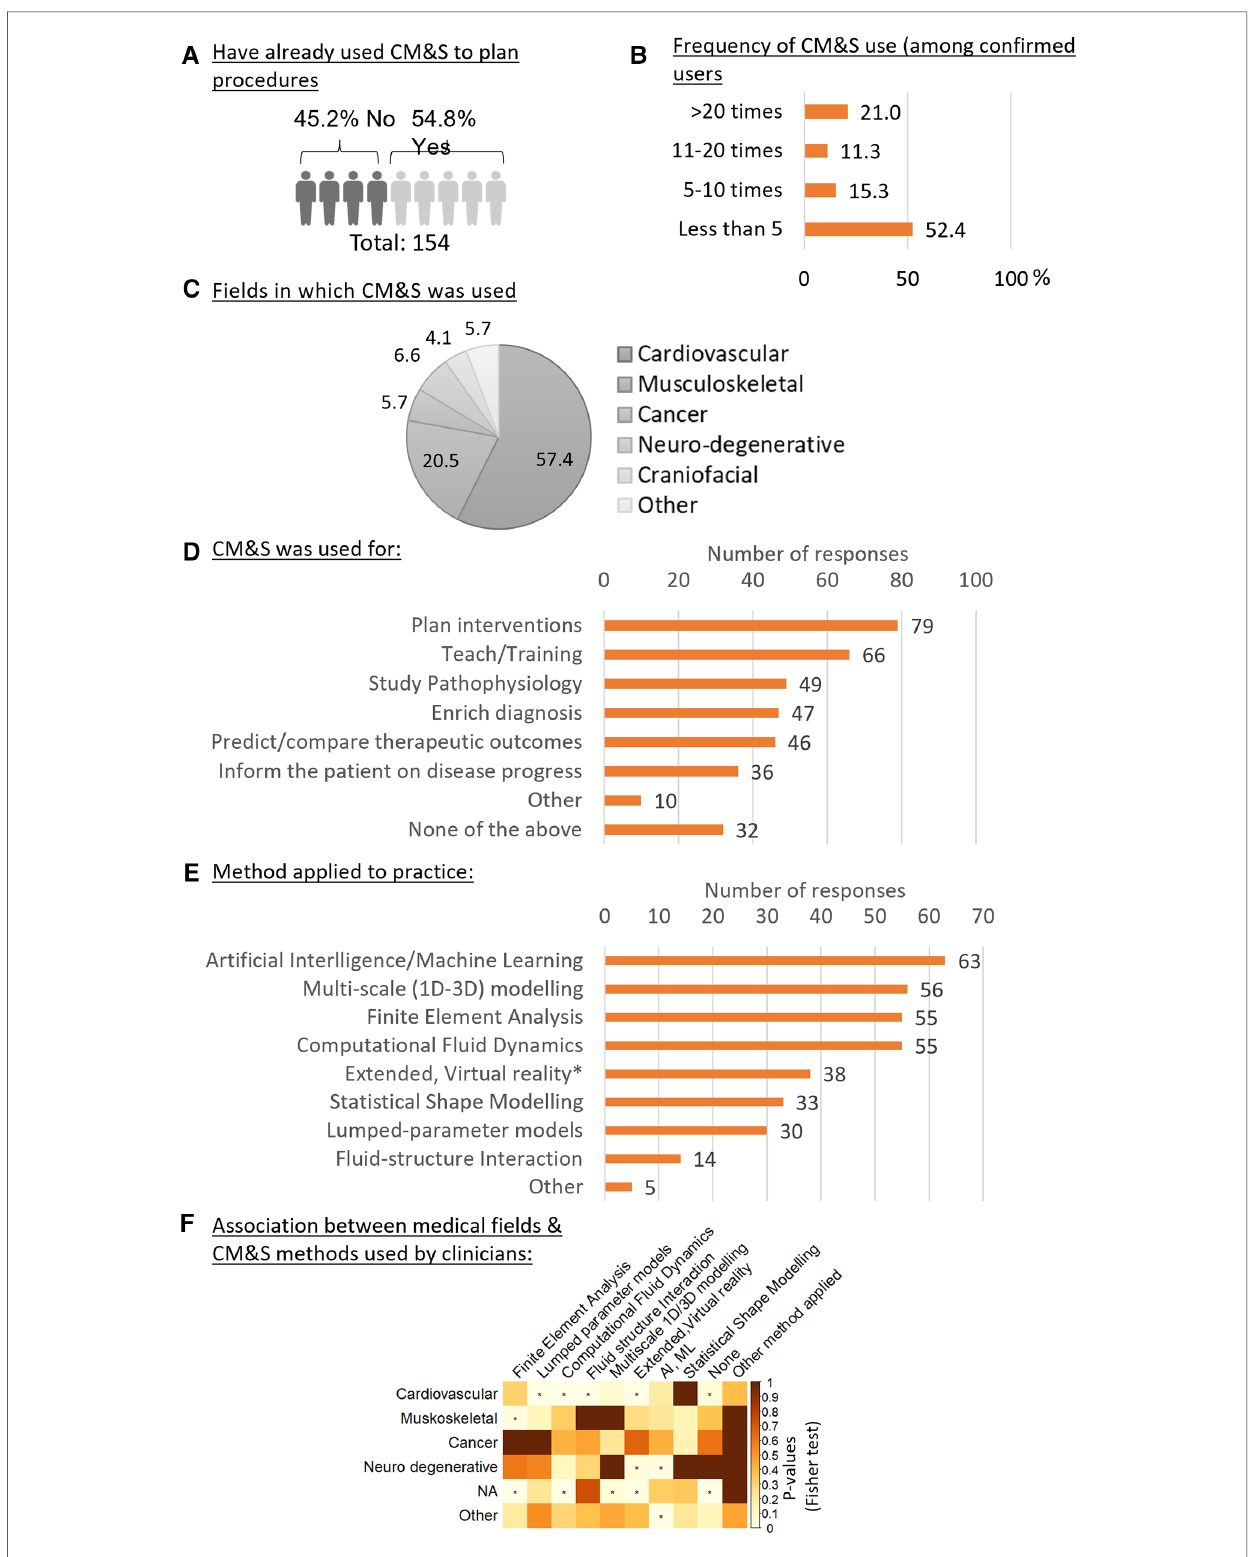
FIGURE 3 Usage of CM&S and related methods in the clinics. ( A ) percentage of clinicians who have already used CM&S for planning procedures (question #10). ( B ) Frequency of usage of CM&S among clinicians who have already used it to plan procedure. ( C ) Fields in which CM&S was used to plan intervention, expressed in percentage of n =122 responses. (question #11) ( D ) Purpose of application of CM&S by clinicians ranked based on number of responses (question #9) ( E ) Ranking of CM&S related methods from the less to the most applied to clinical practice by respondents (question #4). ( F ) Association between the medical fi eld in which respondents have applied CM&S (questions #11) and CM&S method that have been applied by the respondents. Test of independence: Fisher Exact test, the independence is rejected for p -values<0,05, indicated with